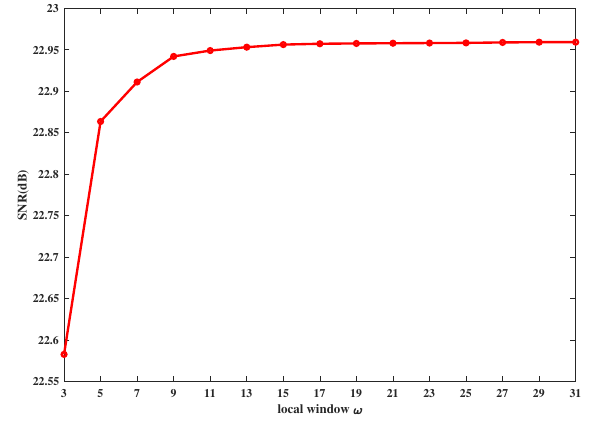
Figure 6. The SNR for results with different ω